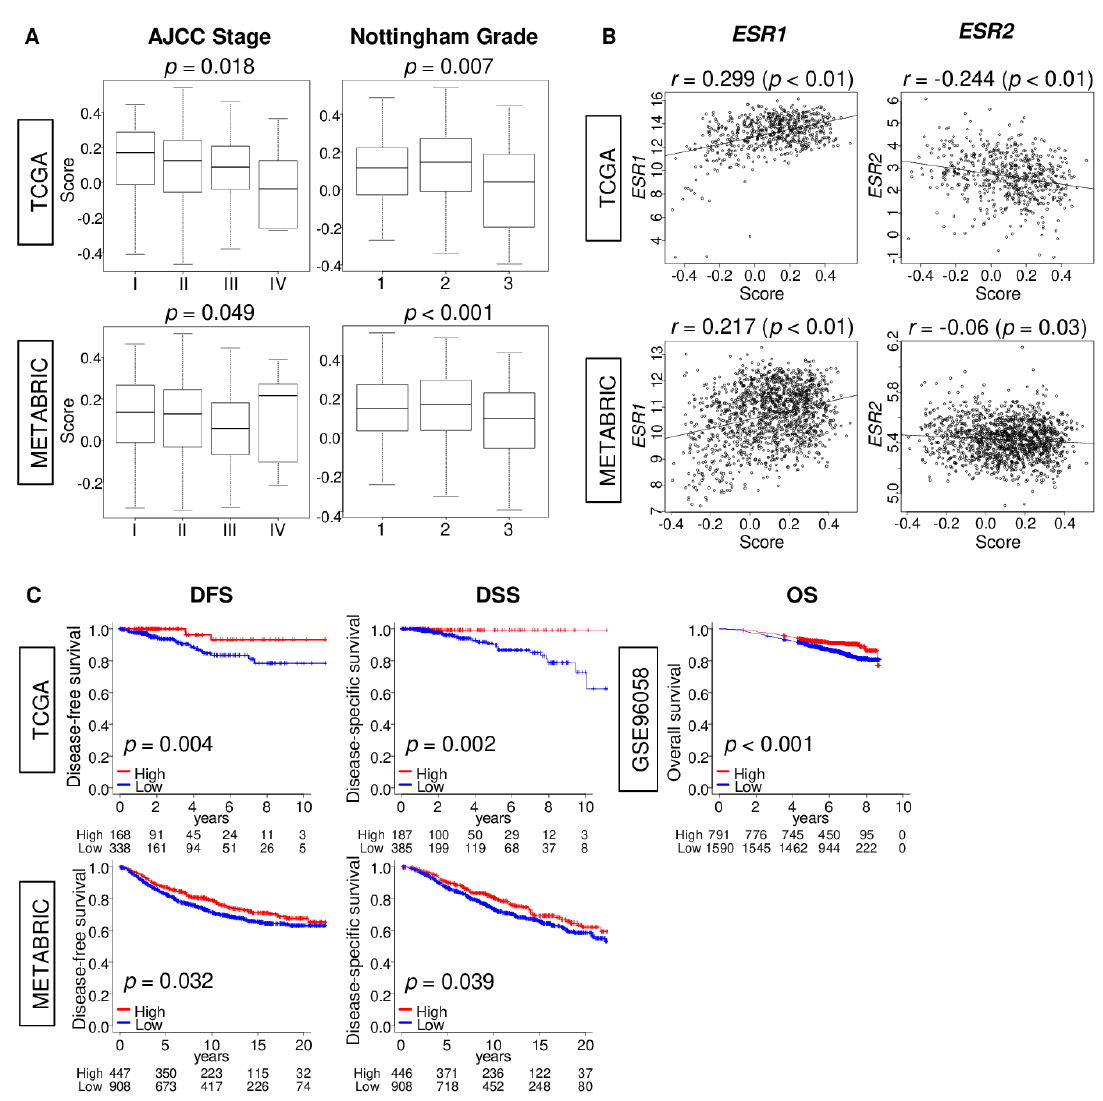
Figure 2. Association of the estrogen response early score with clinical features in estrogen receptor (ER)-positive / human epidermal receptor (HER2)-negative breast cancer. ( A ) Boxplots of the comparison of the estrogen response score by the American Joint Committee on Cancer (AJCC) staging (Stage I-IV), and Nottingham pathological grade in the TCGA and METABRIC cohorts. p -value was calculated by one-way ANOVA test. ( B ) Correlation plots of the score with ESR1 and ESR2 gene expressions in ER-positive / HER2-negative breast cancer in both cohorts. p -value was calculated by Spearman’s rank correlation coe ffi cient. ( C ) Kaplan-Meier survival curve with a log-rank p -value between low- (blue) and high- (red) score in ER-positive / HER2-negative breast cancer with disease-free survival (DFS), disease-specific survival (DSS) in the TCGA and METABRIC cohorts, and overall survival (OS) in the GSE96058 cohort. The top one-third was defined as the high score group within each cohort.